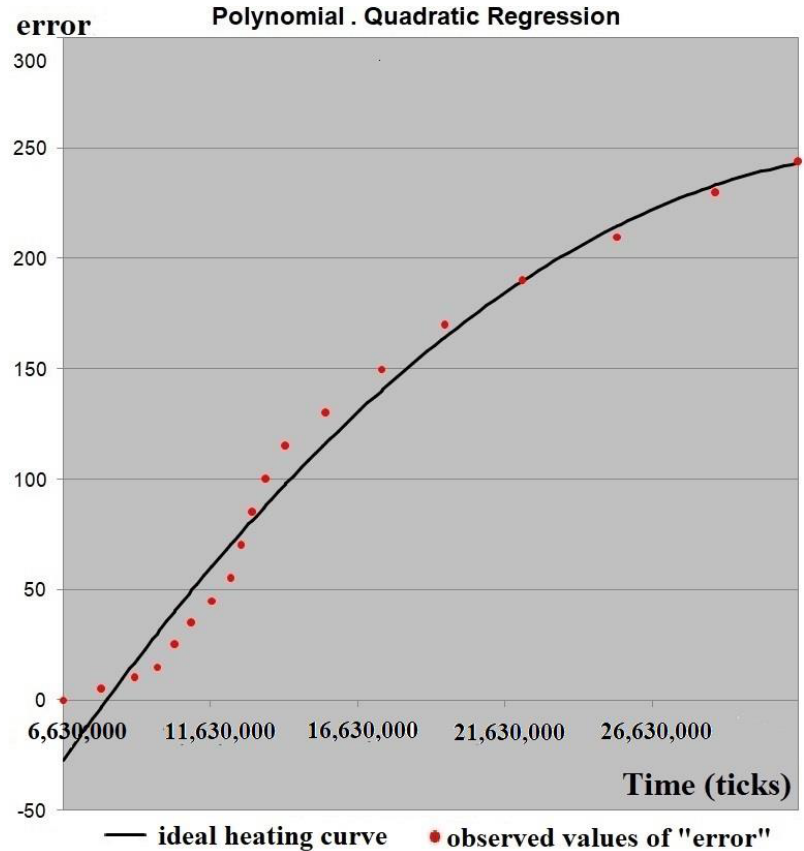
Figure 9. Ideal heating curve of the nozzle with power consumption of 90%.